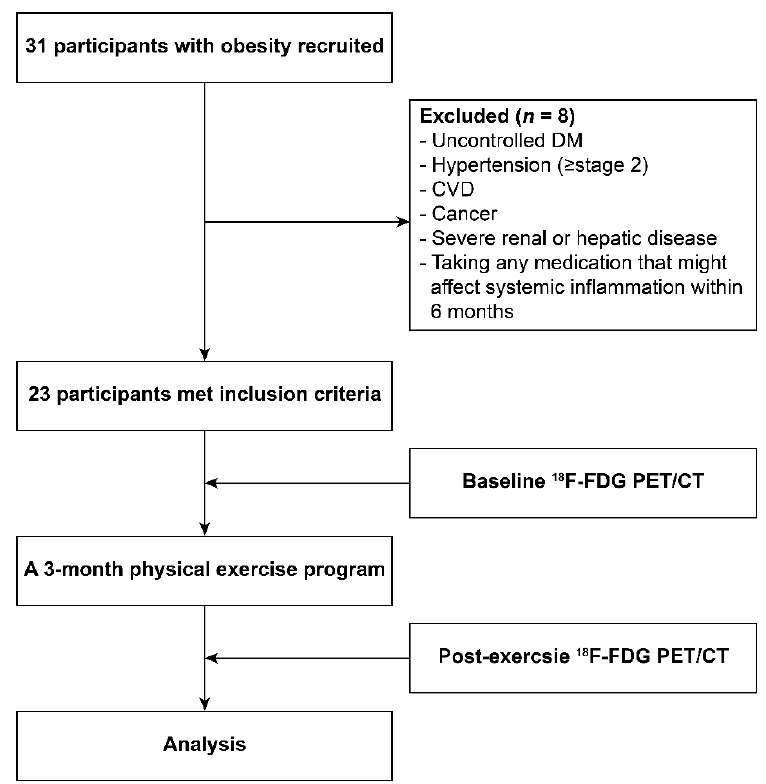
Figure 1. Flowchart of study design. DM, diabetes mellitus; CVD, cardiovascular disease; 18 F-FDG PET/CT, 18 F-fluorodeoxyglucose (FDG) positron emission tomography/computed tomography.